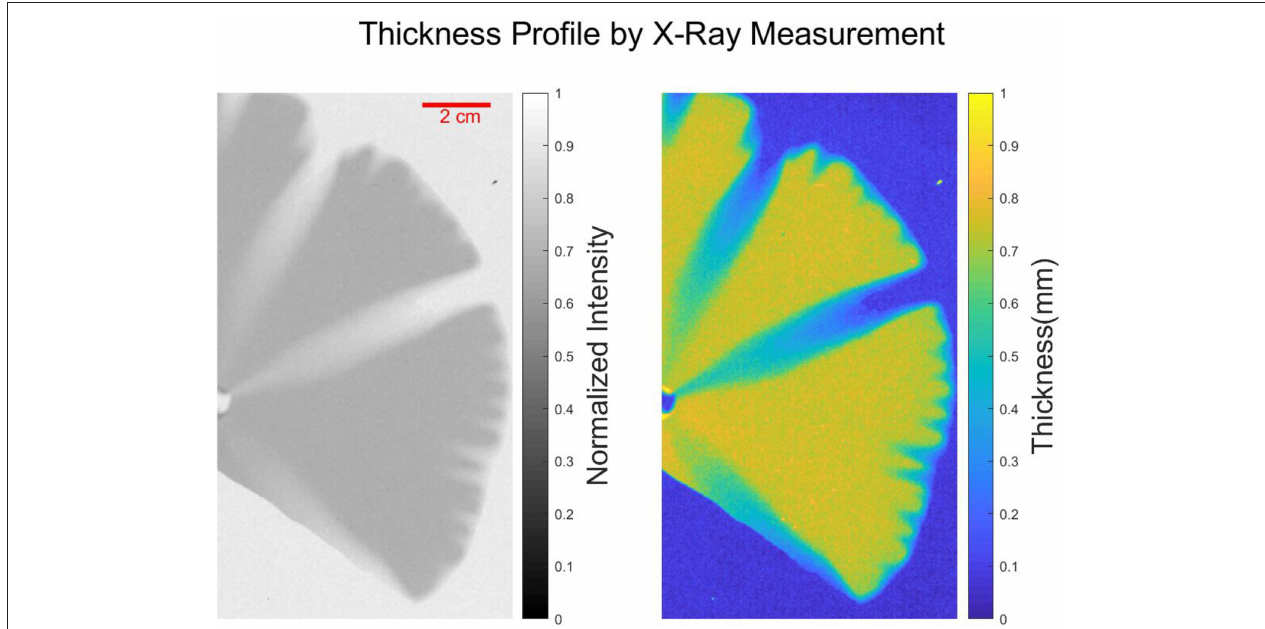
FIGURE 5 | (Left) X-ray image of dissolved plaster sample captured by X-ray thickness gauge REX-CELL 4X from Flow Capture. The gray-scaled picture shown in the left panel is the normalized intensity of the X-ray measurement together with the color bar. (Right) Thickness profile of the dissolved plaster sample is displayed with the gradient-color picture together with the color